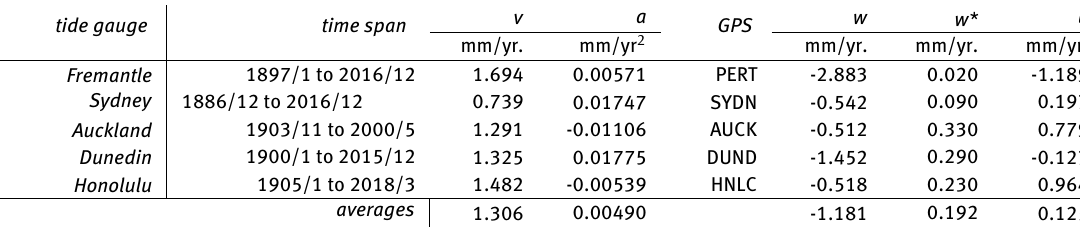
Table 1: Summary of sea-level rise and subsidence results for the LTT stations of Oceania tide gauge time span v a GPS w